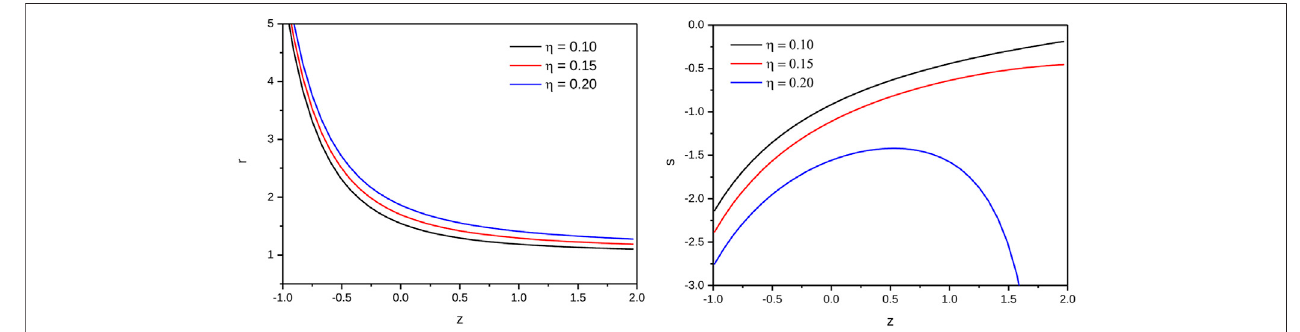
FIGURE 7 | Plot of r and s of ghost dark energy f ( Q ) gravity model versus redshift for the appropriate choice of constants.